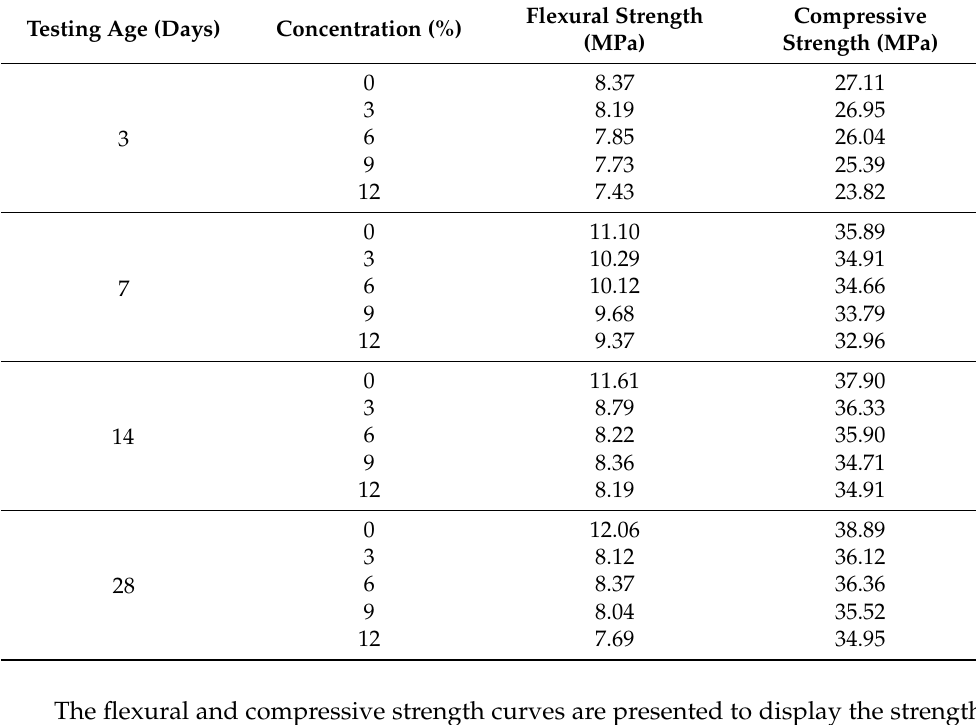
Table 3. The data of flexural and compressive test.